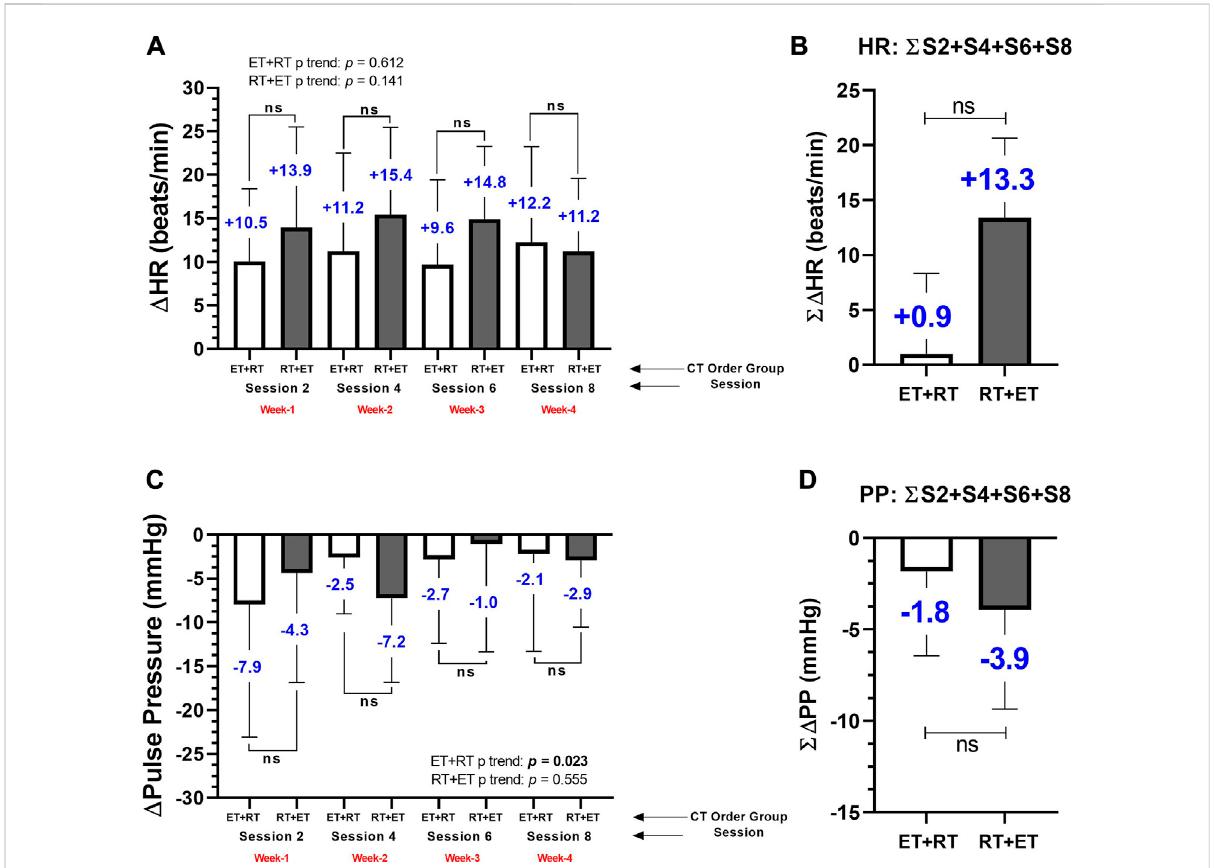
FIGURE 5 Acute delta changes in the heart rate at rest by each delta changes by session (A) , and by the sum of 4 exercise sessions (B) , and pulse pressure by each delta changes by session (C) , and by the sum of 4 exercise sessions (D) during 4 weeks (eight exercise sessions) monitored four times during session 2 (second CT session), session 4 (fourth CT session), session 6 (sixth CT session), and session 8 (eight CT session) in morbid obesity patients ’ participants of two orders of concurrent training. Groups are described as (ET + RT) endurance training plus resistance training group and (RT + ET) resistancetrainingplusendurancetraininggroup.Outcomesaredescribedas( Δ HR)deltaofheartrateatrest (A) ,andtheaverage(i.e.,S2+S4+S6+S8)ofthesefour measurementsineachgroup,areabbreviatedas (cid:1) Δ HR (B) ,( Δ PulsePressure)deltachangesofpulsepressure,andtheaverage(i.e.,S2+S4+S6+S8)ofthesefour measurements in each group, are abbreviated as (cid:1) Δ PP (D) . (ns) denotes no signi fi cant differences p >